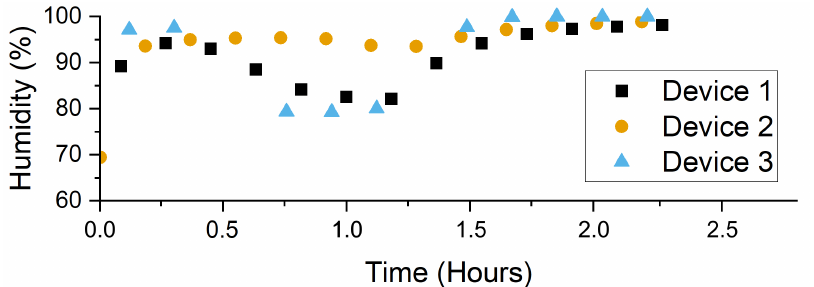
Figure 7. The humidity fluctuations in the chamber as measured by three identical devices during the humidity test. Device 2 was physically closer to the humidifier, thus reflecting higher humidity